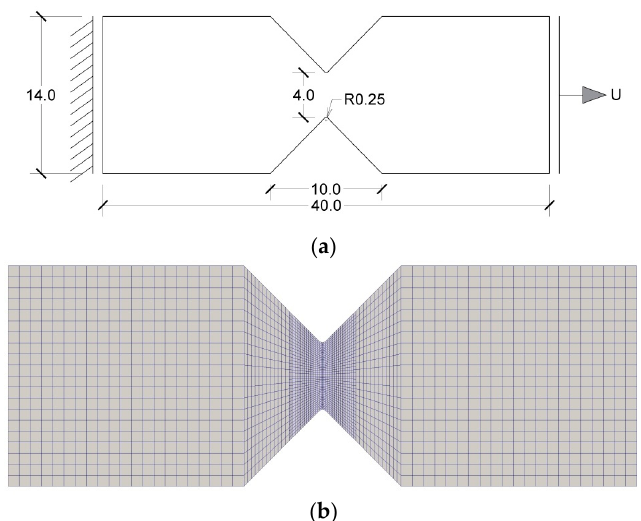
Figure 3. The V ‐ notched plane strain tension test: ( a ) the geometry and associated dimensions (in mm) and ( b ) the finite element discretization.